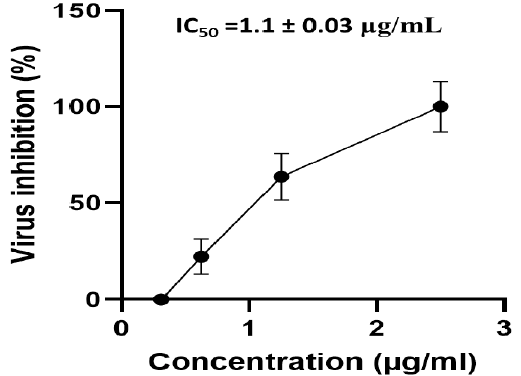
Figure 3. A curve showing the effect of APEE different concentrations on the viability of NRC-03-nhCoV. The results are expressed as mean ± SD as the experiments were performed in three independent triplicates.